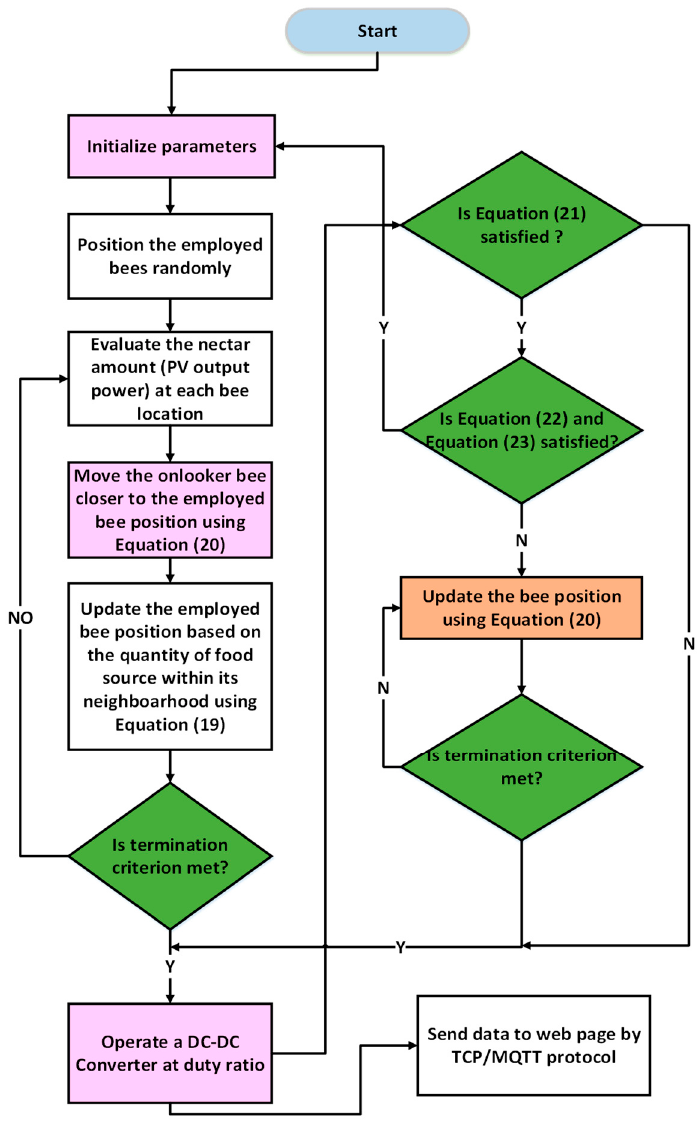
Figure 9. Flowchart of proposed algorithm.